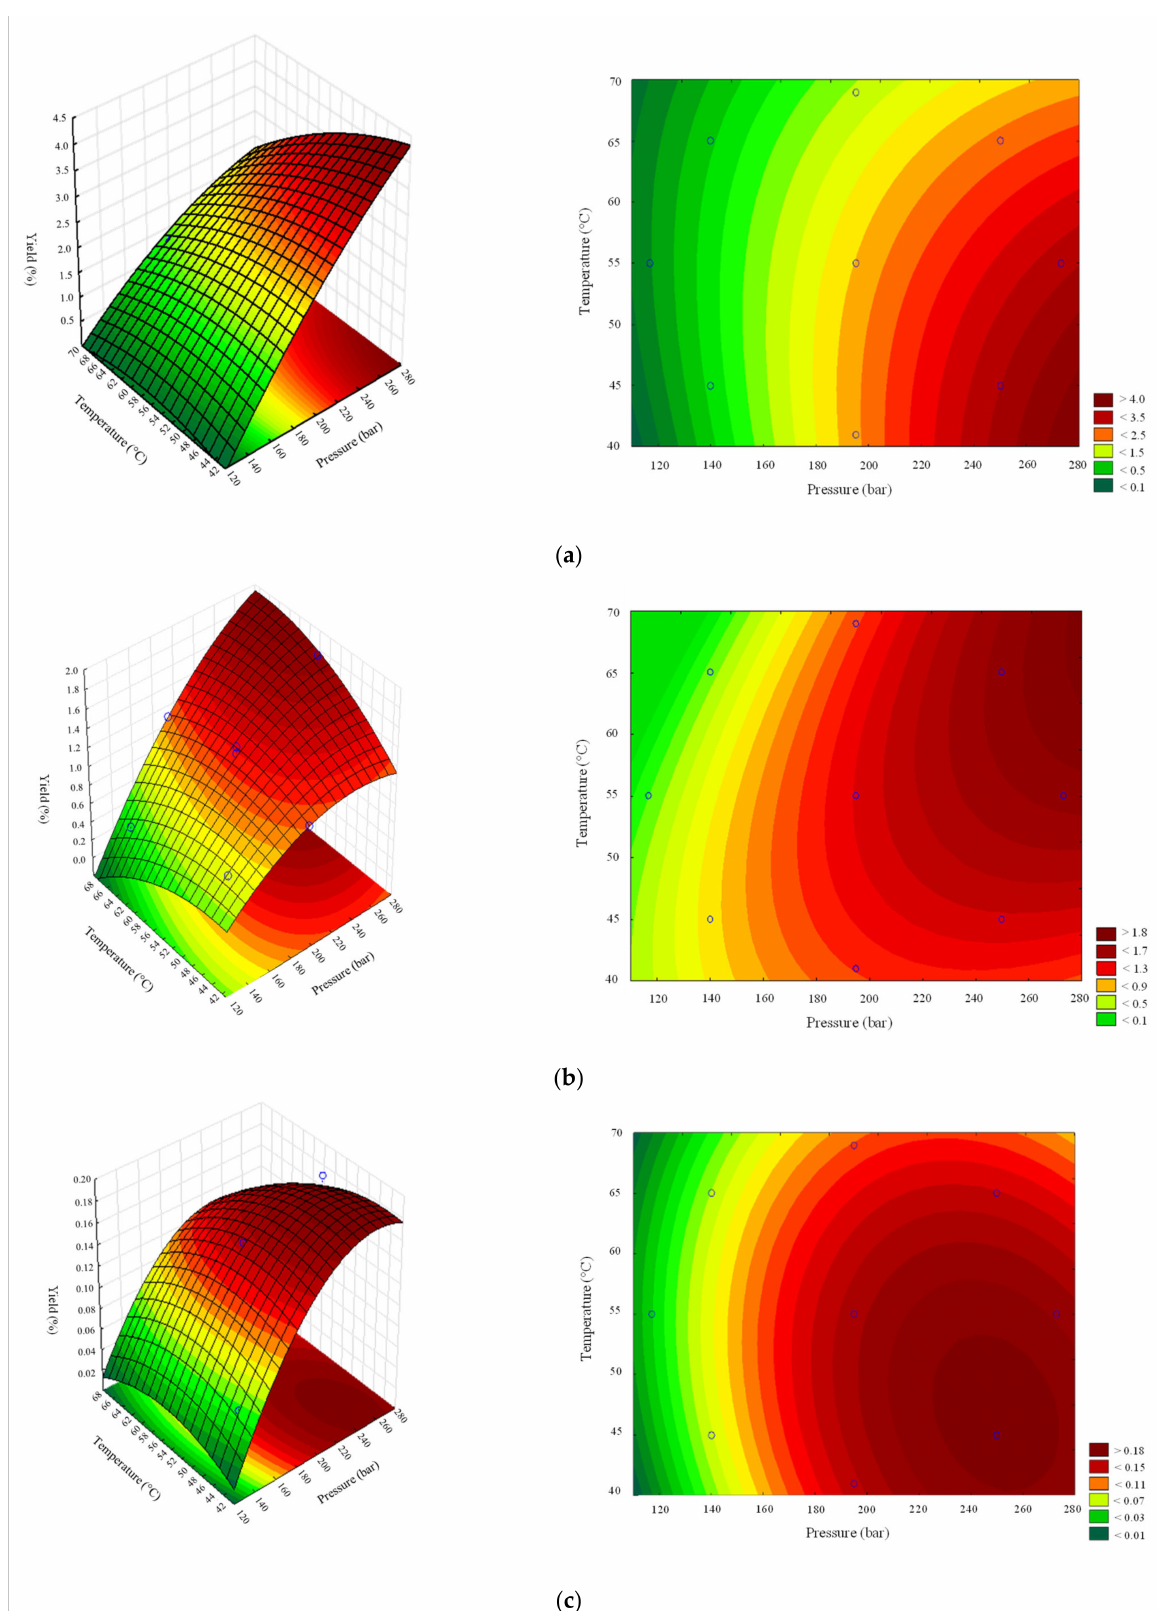
Figure 1. Response surface methodology (RSM) applied for ( a ) Mo seed, ( b ) leaf, and ( c ) root SFE-CO 2 extracts, according to DOE